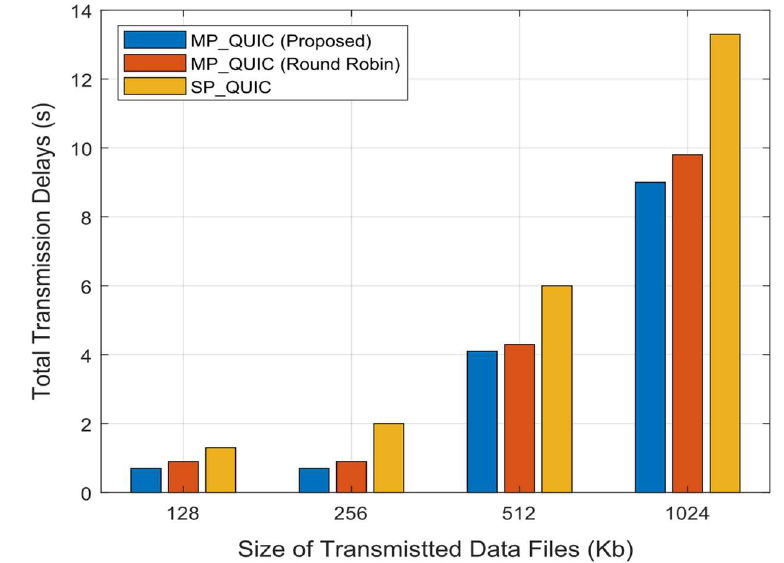
Figure 8. Total transmission delays for different sizes of data files transmitted.